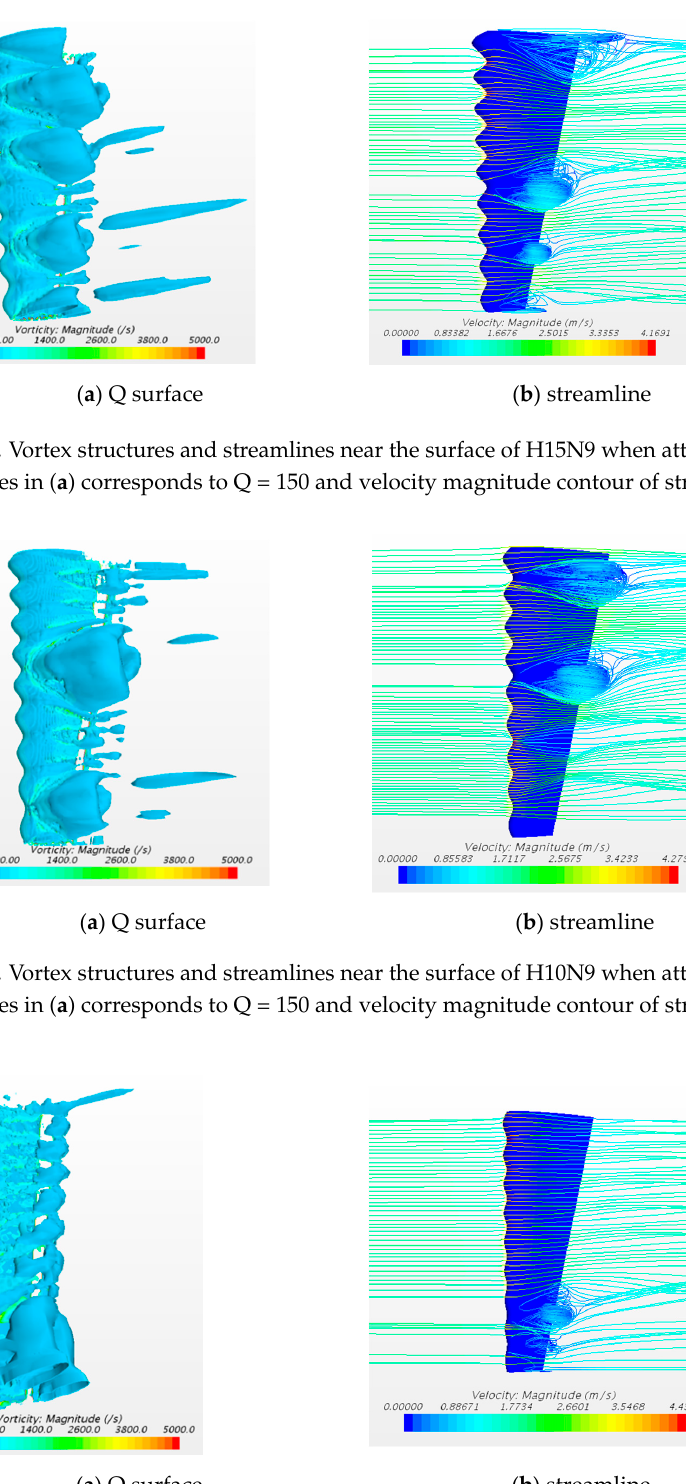
Figure 11. Vortex structures and streamlines near the surface of the base blade when attack angle is 24° (the iso-surfaces in ( a ) corresponds to Q = 150 and velocity magnitude contour of streamline in ( b )).